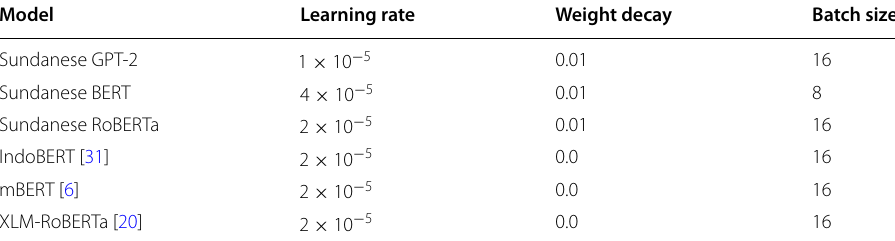
Table 4 Hyperparameters used to fine-tune pre-trained models